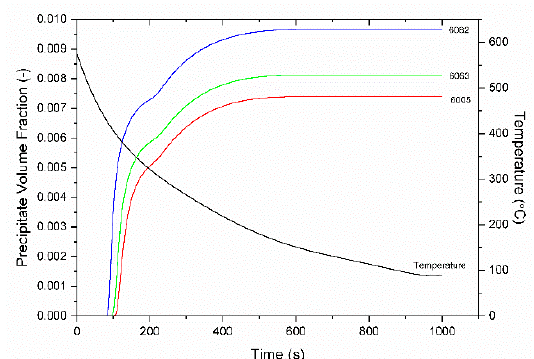
Figure 15. Evolution of the volume fraction of Mg 2 Si precipitates with time during homogenization cooling for 6063, 6005, and 6082 alloys. The cooling curve is also indicated.